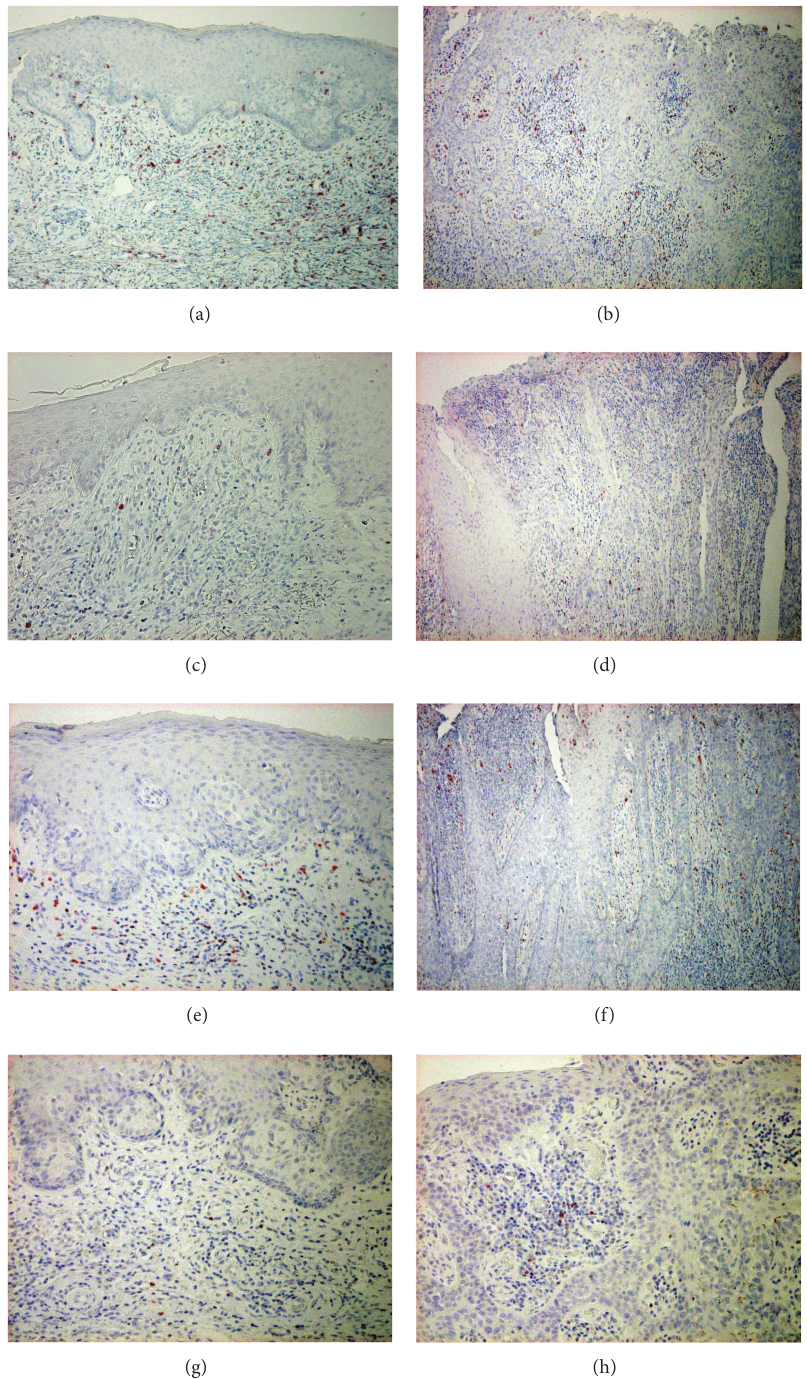
Figure 1: CD8, granulysin, TIA-1, and perforin in noninvasive and invasive EMPD. Paraffin-embedded tissue samples from patients with invasive and noninvasive EMPD were deparaffinized and stained using a combination of anti-CD8 Ab ((a) and (b)) and anti-granulysin Ab ((c) and (d)), anti-TIA-1 Ab ((e) and (f)) or antiperforin Ab ((g) and (h)). Noninvasive EMPD: (a), (c), (e), and (g); invasive EMPD: (b), (d), (f), and (h). Original manifestation: × 200. Sections were developed with liquid permanent